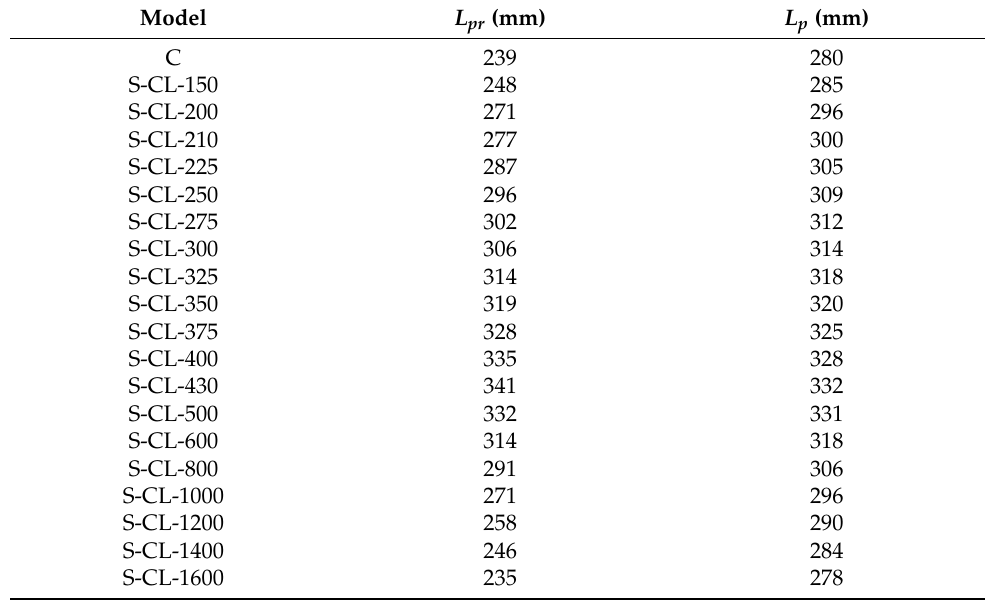
Table 6. Physical and Equivalent Plastic Hinge Lengths of the Simulated